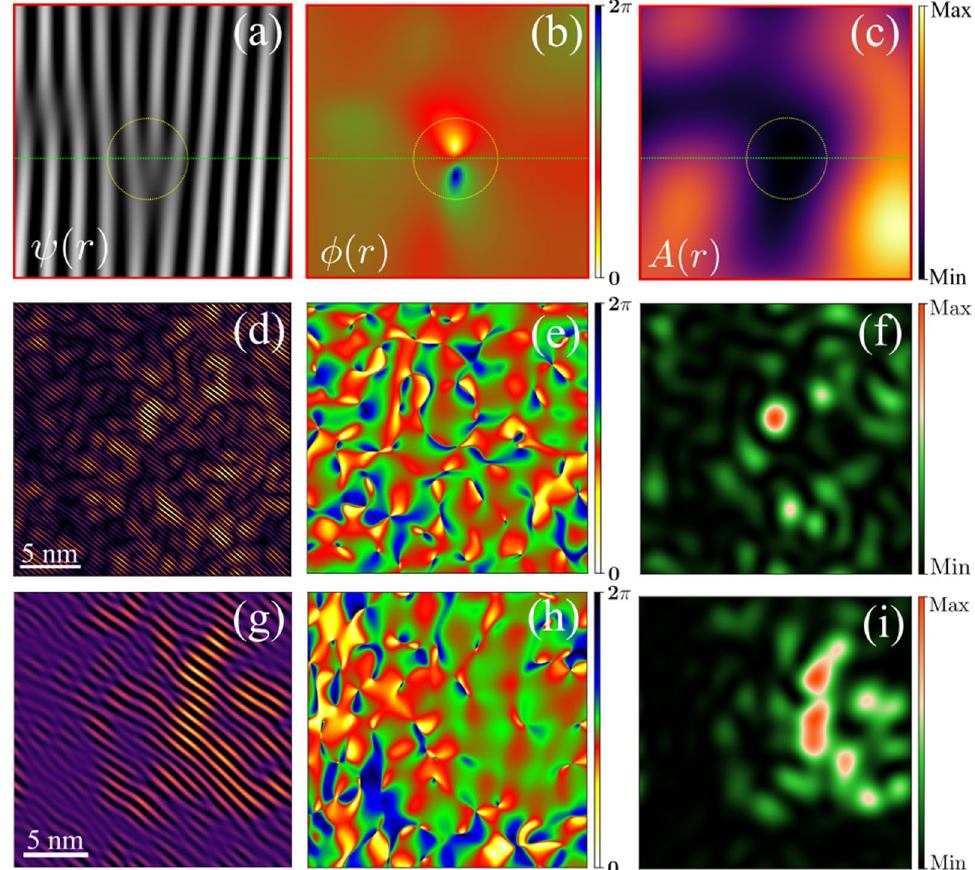
Figure 3. Exemplifying the coarse grain phase mapping process. ( a – c ) Complex field ψ q (� r ) of a unidirectional density modulation and the corresponding spatial map of φ( r ) , A ( r ) , respectively. The circles mark the corresponding exact equivalent location. ( d , g ) Unidirectional Density modulation map of COM and ICOM phase. ( e , h ) Spatial φ( r ) fluctuation map of COM and ICOM phase. ( f , i ) Spatial A ( r ) fluctuation map of COM and ICOM lattice